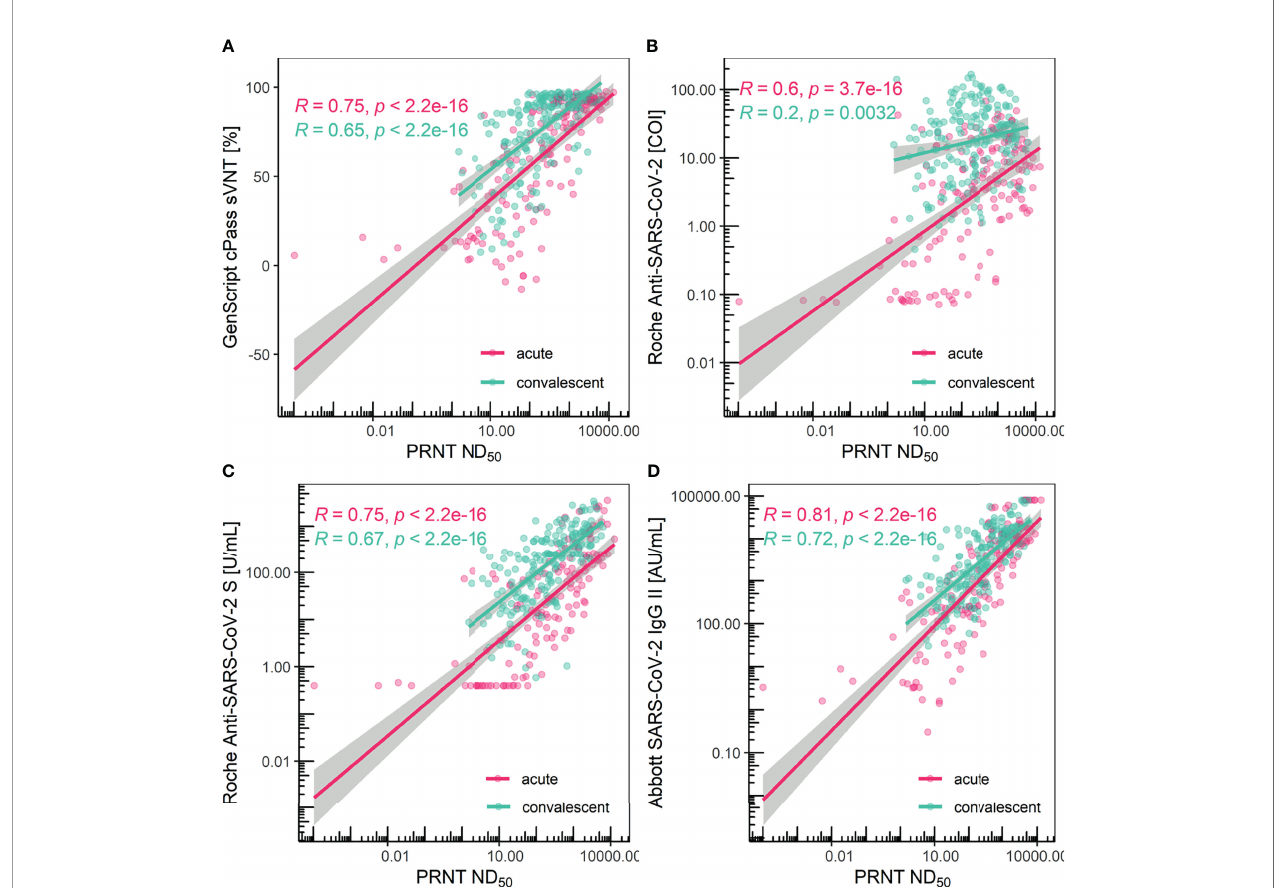
FIGURE 3 | Scatter plot and Pearson ’ s correlation for each method grouped with acute/convalescent phase. (A) GenScript cPass sVNT, (B) Roche Elecsys Anti- SARS-CoV-2, (C) Roche ElecsysAnti-SARS-CoV2 S, and (D) Abbott AdviseDxSARS-CoV2 IgG II were compared with PRNT, respectively. Each colored line depicts the linear regression model and the surroundinggrey-colored area represents the 95% con fi dence